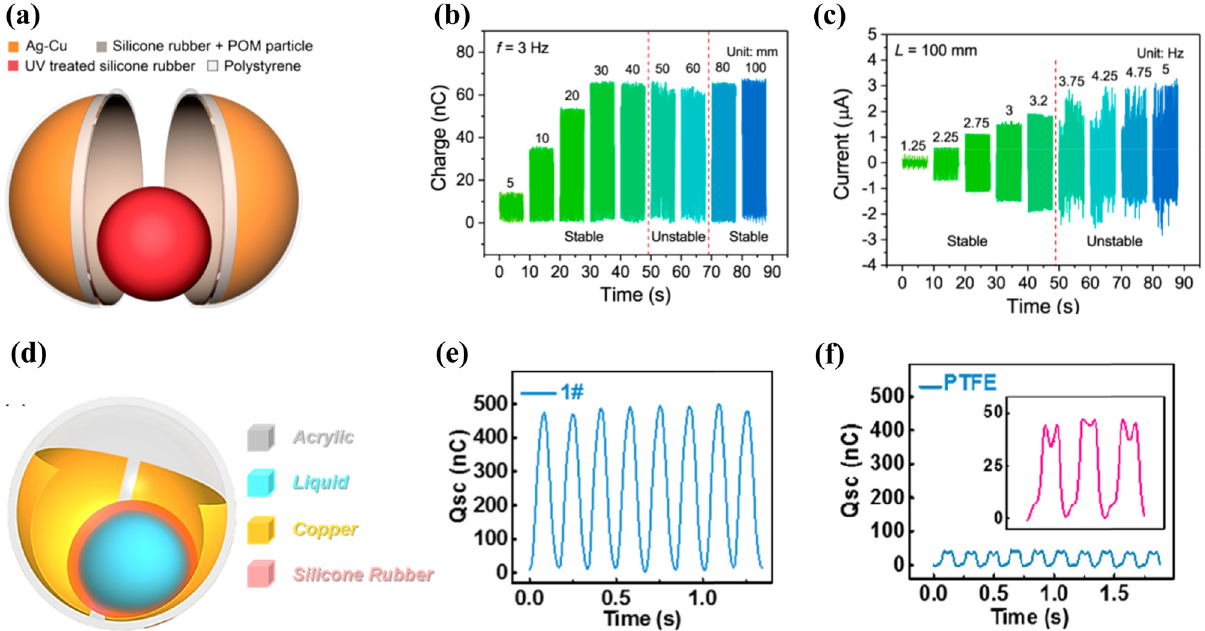
Figure 3: ( a ) Schematic structure of the S - TENG unit, ( b ) the relationship between the transferred charge and harmonic stirring displacement, ( c ) the relationship between the transferred charge and the amplitude of the small ball displacement [ 50 ] , ( d ) structure of a soft contact model spherical TENG ( SS - TENG ) with a fl exible rolling spherical surface, and ( e and f ) maximum transfer charge of SS - TENG and S - TENG ( illustration shows an enlarged image ) [ 53 ]